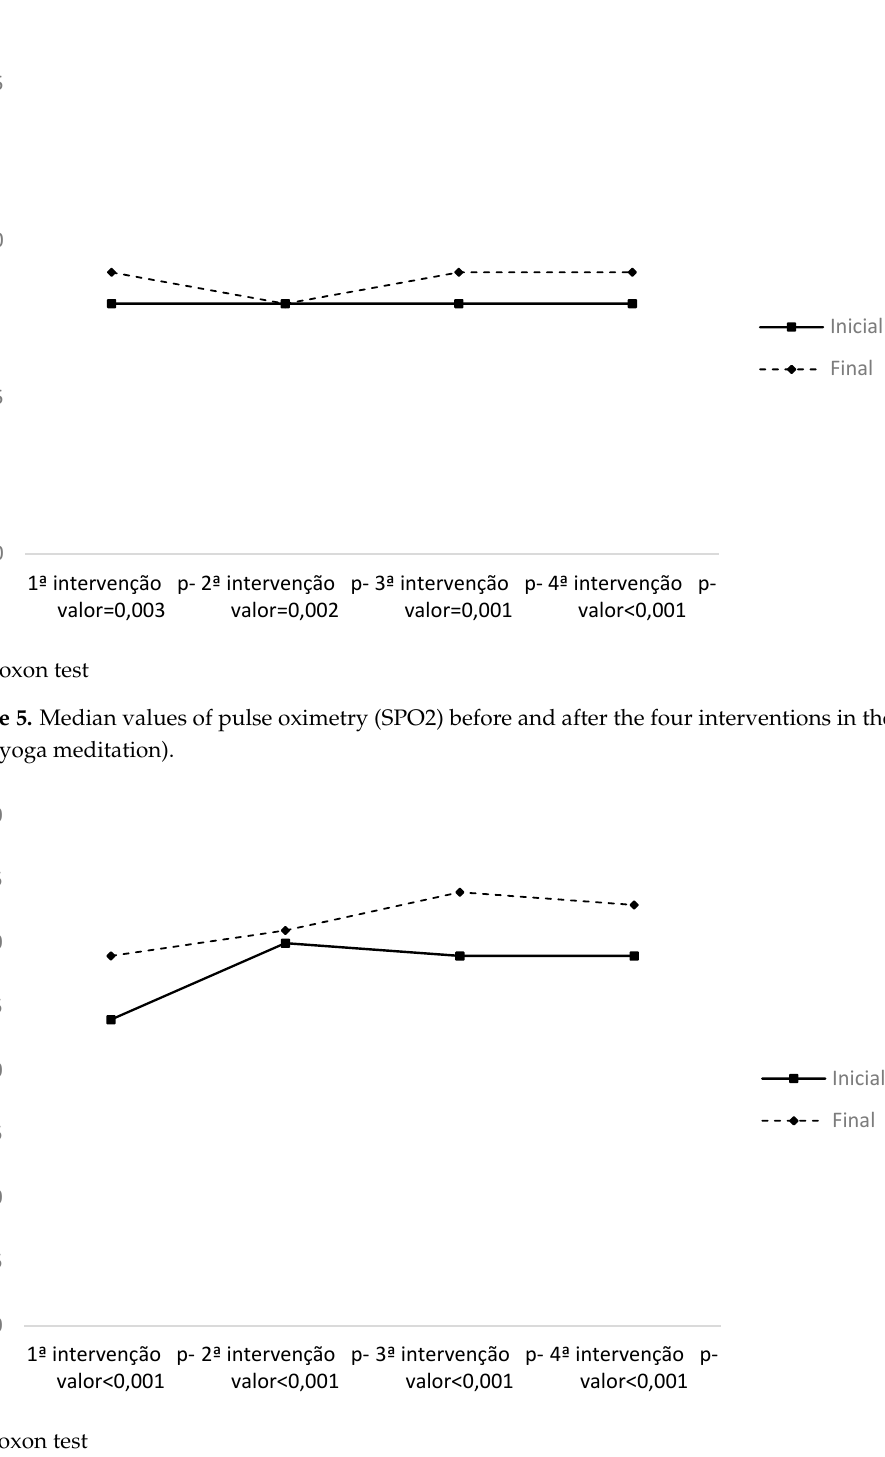
Figure 6. Median values of systolic blood pressure (SBP) before and after the four interventions in the CG (educational activity).